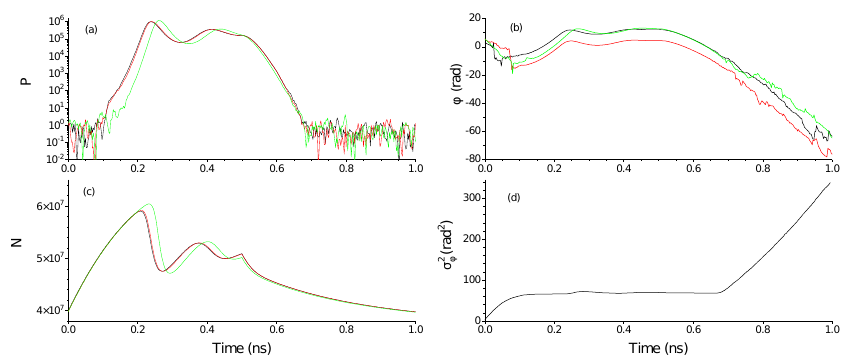
Figure 2. ( a ) Photon number, ( b ) phase, and ( c ) carrier number dynamical evolution for three different realizations are shown with black, red, and green lines in a temporal window of duration T . ( d ) Variance of the phase as a function of t . In this figure T = 1 ns and the three realizations are extracted from the time traces of Figure